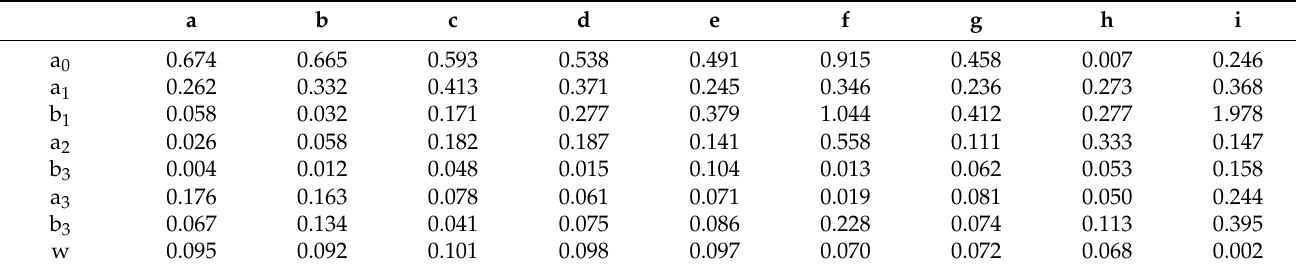
Table 3. Parameter values of each fitted